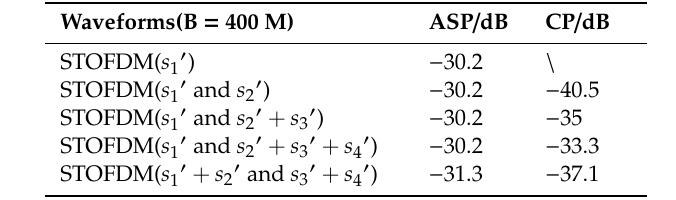
Table 5. ASP and CP of STOFDM signals with di ff erent number of signals.